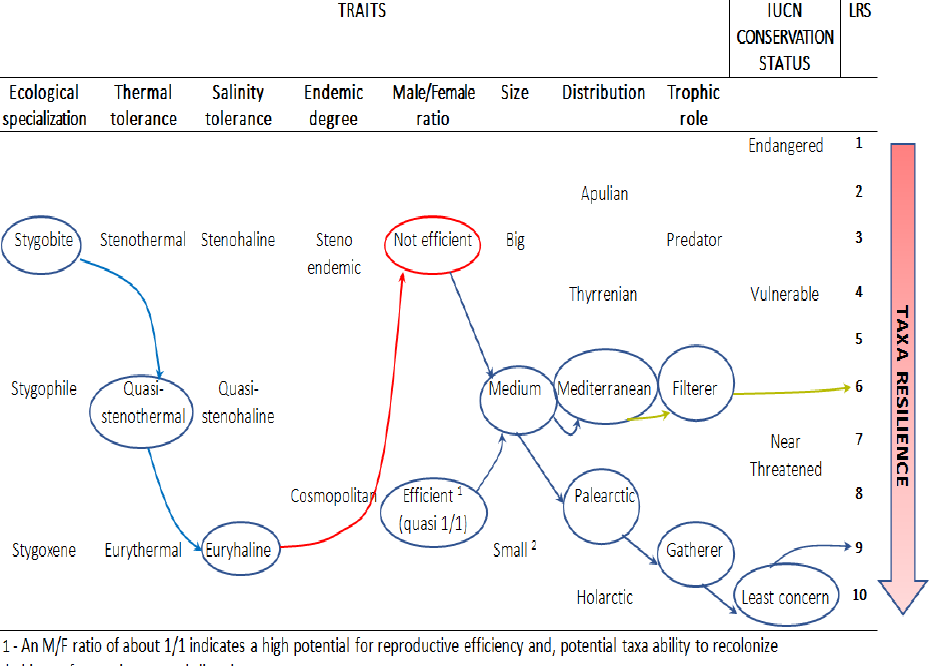
Table 2. Results of the bio-speleological sampling of stygophiles (Sf), stygoxenes (Sg), and stygo- bites (Sb) in groundwater habitats of the Bosco sinkhole, Rotolo cave, and wells.